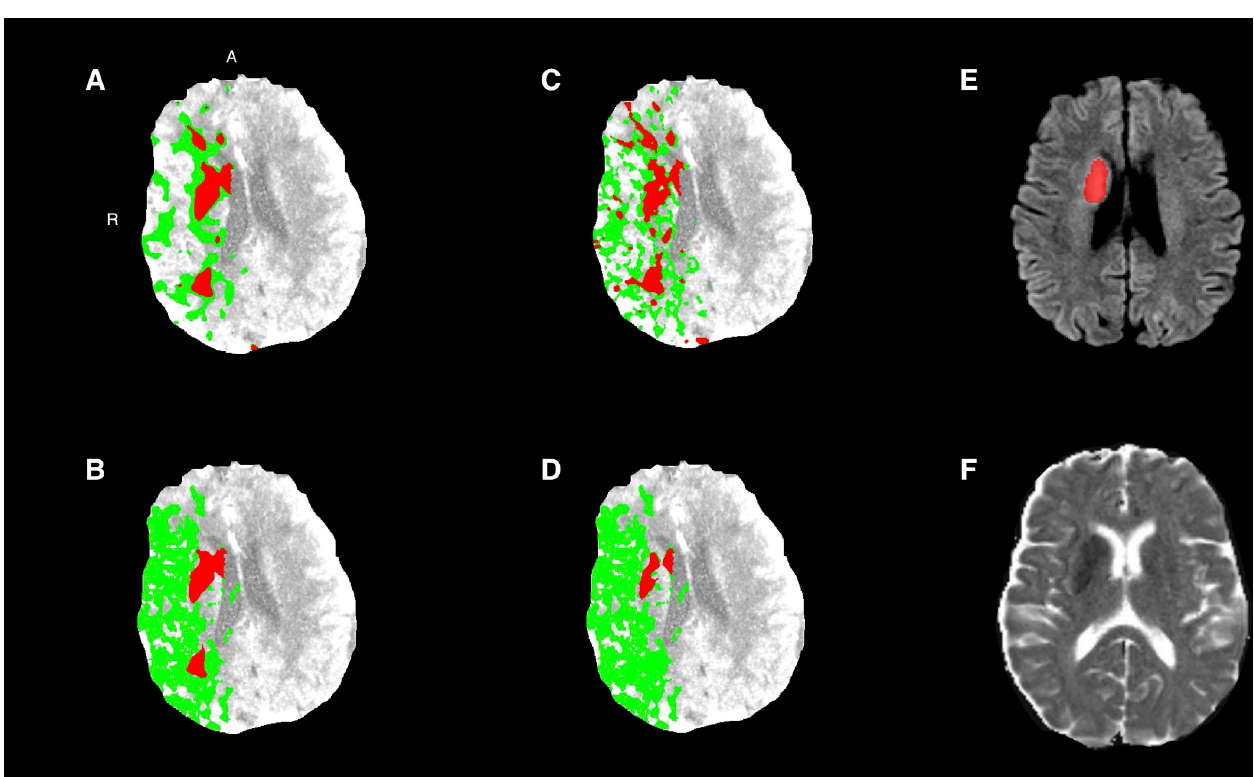
Fig 3. Baseline CTP of a patient with a right-sided M1 occlusion with successful reperfusion (eTICI 3). The ischemic core (red) and penumbra (green) for (a) approach 1, (b) approach 2, (c) approach 3, and (d) approach 4. (e) Follow-up DWI acquired at 17 hours after baseline imaging and (f) follow-up DWI image with follow-up infarct segmentation (red). A = anterior; CTP = CT perfusion; DWI = diffusion weighted imaging; MRI = magnetic resonance imaging; R =